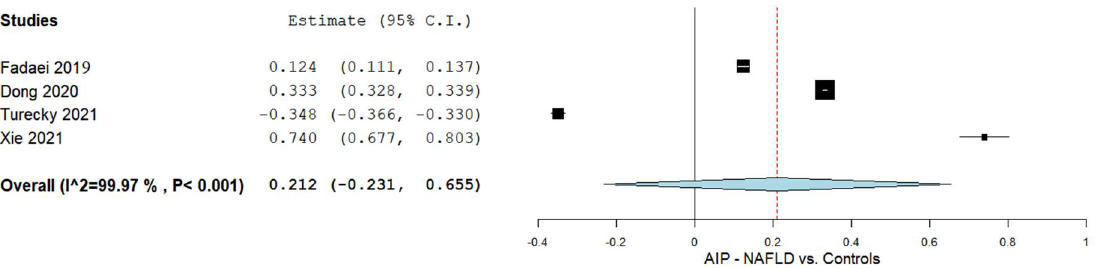
Figure 2. The AIP in the NAFLD patients vs. the controls. AIP—Atherogenic index of plasma; NAFLD—Non-alcoholic fatty liver disease.